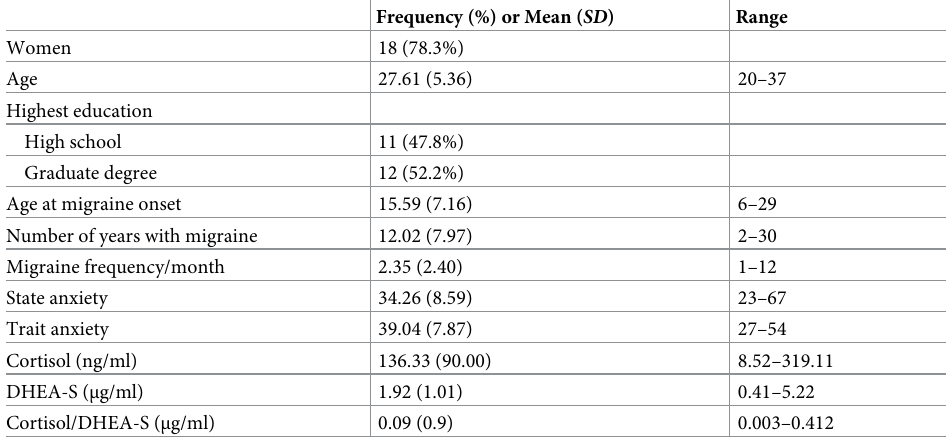
Table 2. Demographic data and clinical characteristics of participants (N =